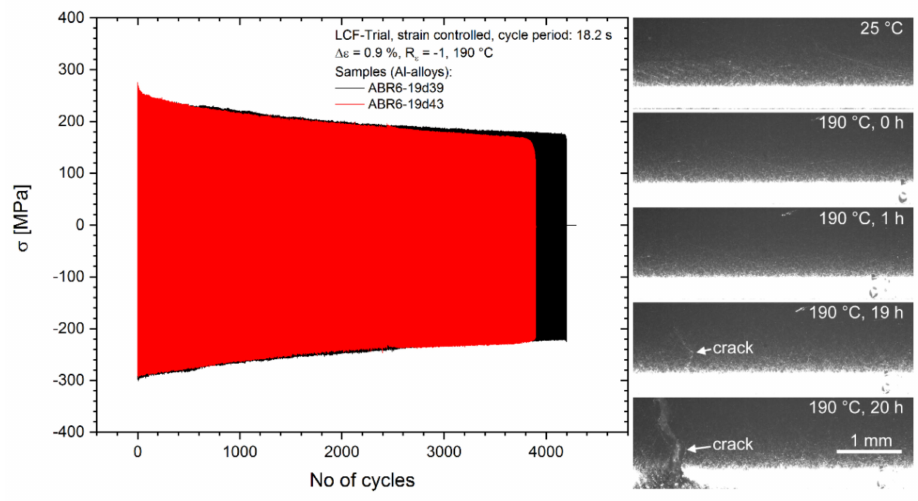
Figure 8. Strain-controlled low cycle fatigue (LCF) tests on AlSi piston alloy for automotive applications. Crack propagation can be observed during the experiment.